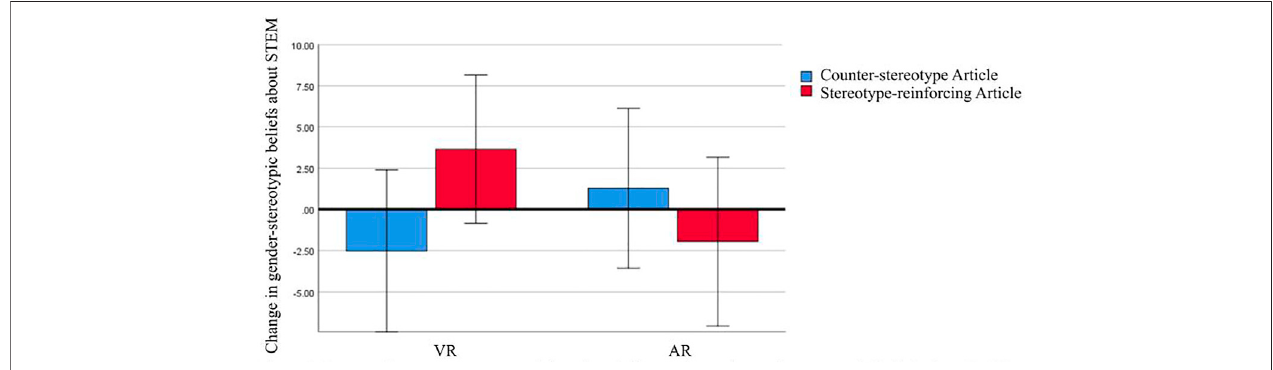
FIGURE 2 | Impact of stereotype threat prompt article and modality on change in gender-stereotypic beliefs about STEM fi elds (means and con fi dence intervals).